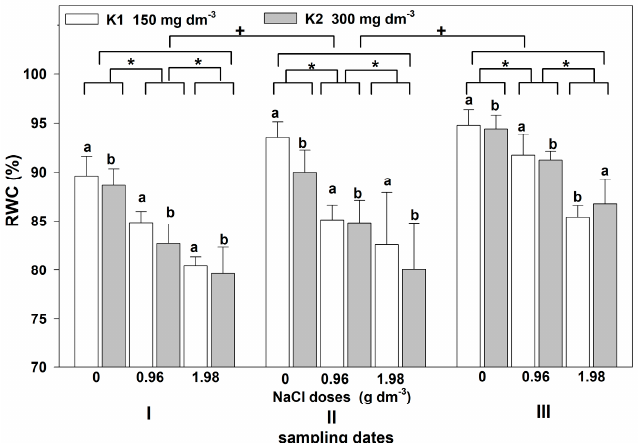
Figure 4. The effect of NaCl doses on RWC in leaves of zinnia grown in the peat substrate supplemented with two potassium doses. Letters a and b show a significant effect of potassium, an asterisk (*) shows a significant effect of salt doses, and + shows a significant effect of the sampling date (I, II, III). Values are expressed as the means (n = 5) ± standard deviation.